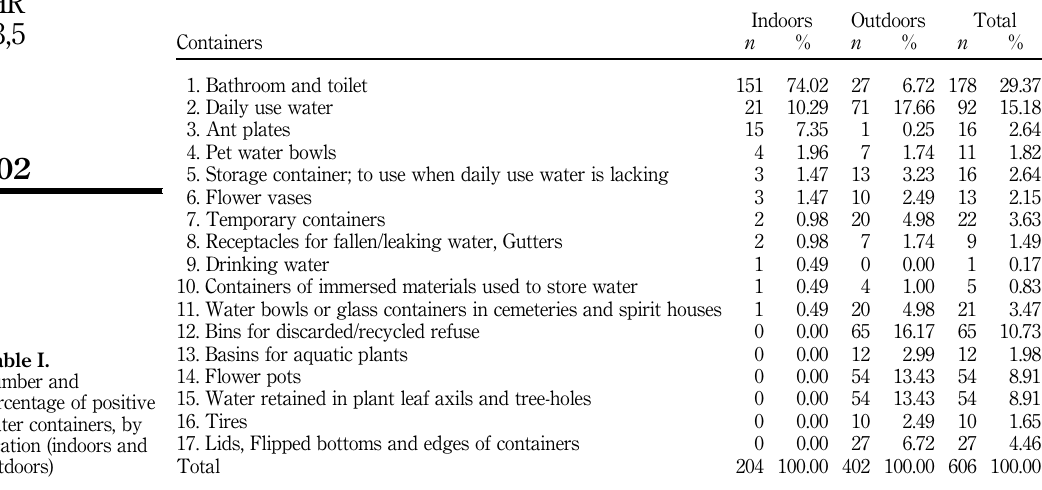
Table I. Number and percentage of positive water containers, by location (indoors and